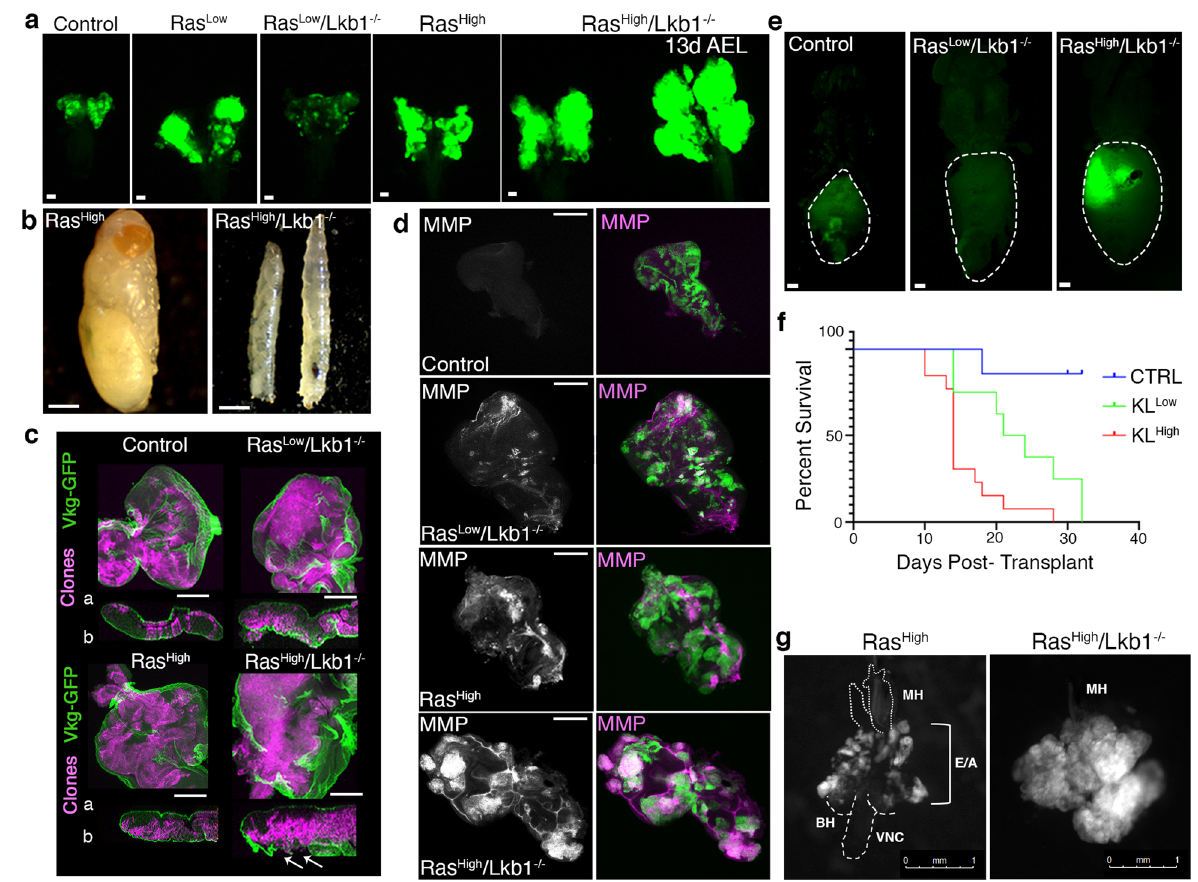
Fig. 3 Oncogenic Ras High promotes the malignant transformation of Lkb1 mutant tissue. a Fluorescent images of 3rd instar larval eye-imaginal discs (exception labeled ‘ 13d AEL ’ ) carrying GFP + clones of the indicated genotypes (control = FRT82B ). Images are representative of n = 10 independent eye- imaginal discs per genotype. Scale bar, 20 µ m. AEL = after egg-lay. The stage ‘ 13 days AEL ’ is indicative of a larva that failed to pupate at day ~5d AEL, and is a classic neoplastic phenotype. b Representative bright fi eld image of the lethal stage of a fl y carrying Ras High clones (left) and Ras High /Lkb1 − / − clones (right). Note that both age-matched third instar and giant larvae are shown for the Ras High /Lkb1 − / − genotype. c Confocal images of eye-imaginal discs carrying RFP + clones (magenta) of the indicated genotypes and expressing type IV collagen-GFP (Vkg-GFP). White arrow indicates breaks in Vkg-GFP. a = apical, b = basal. Images are representative of n = 5 independent eye-imaginal discs per genotype. Scale bar, 100 µ m. d Confocal images of third instar eye discs carrying GFP + clones of the indicated genotypes, and stained for matrix metalloproteinase 1 (MMP1, magenta in overalay). Images are representative of n = 10 independent eye-imaginal discs per genotype. Scale bar, 100 µ m. e Fluorescent images of w 1118 adult virgin female hosts carrying transplanted allografts of 3rd instar eye-imaginal discs with GFP + clones of the indicated genotypes. Scale bar, 100 µ m. f Quanti fi cation of survival post- transplant in allograft assay. Survival was measured from 7 days post-transplant to time of death. CTRL (FRT82B, n = 7), KL Low (Ras Low /Lkb1 − / − , n = 8), and KL High (Ras High /Lkb1 − / − , n = 13) (CTRL-KL Low , ** p = 0.0030, CTRL-KL High , *** p = 0.0001, KL Low - KL High , * p = 0.0129, Log-rank test). g Representative fl uorescent images of dissected cephalic complexes and ventral nerve cord (VNC) from larvae carrying GFP + clones (white) of the indicated genotypes. BH = brain hemispheres; E/A = eye/antennal discs, MH = mouth hooks. The Ras High /Lkb1 − / − tissue completely invades and obscures contiguous organs. Scale bar, 1 mm. Images are representative of n = 10 cephalic